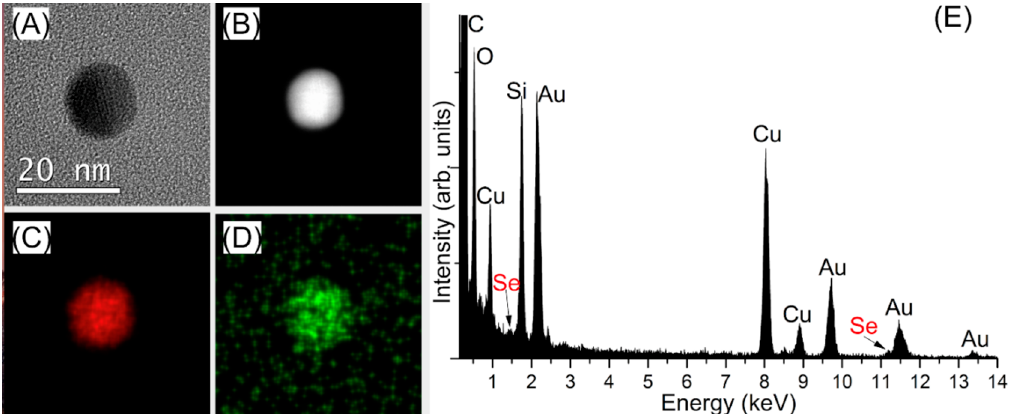
Figure 2. Analysis of Se-AuNPs using the synthesized nanoparticles, confirming the successful functionalization with SeCyst ( A ) TEM image ( B ) HAADF STEM image ( C ) Au EDX map ( D ) Se EDX map ( E ) EDX spectrum from the analyzed area, with both Au M α and Se L α signals (C, O, Si and Cu may be from the supporting TEM grid and carbon film).